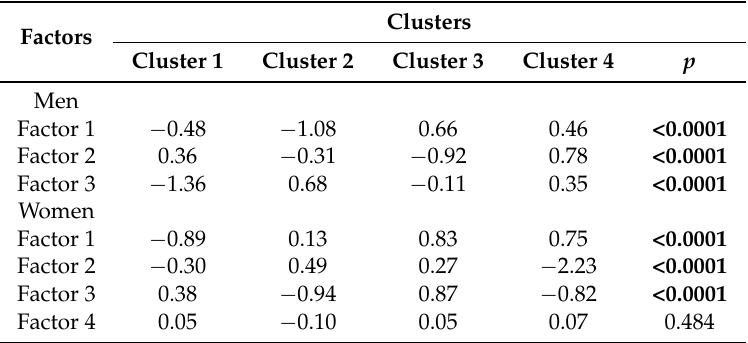
Table 5. Cluster means of factor scores according to clusters for men and women. Factors